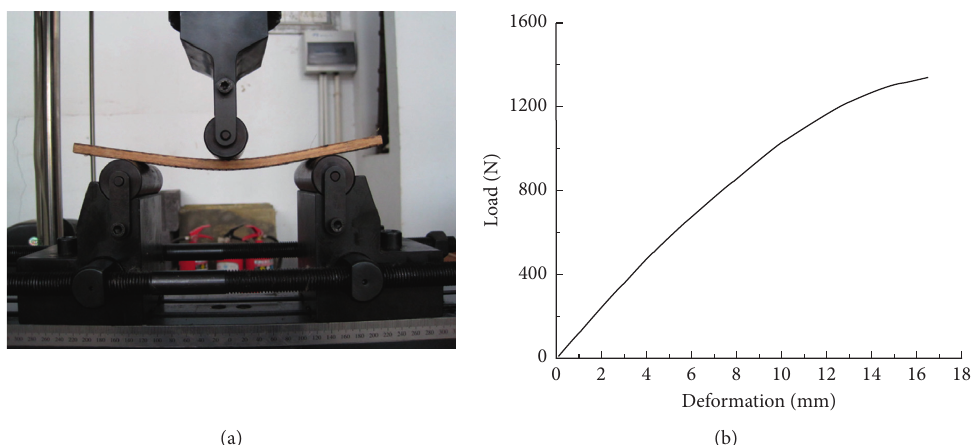
Figure 3: (a) Typical test for bamboo plywood. (b) Load-deformation curve of specimens.